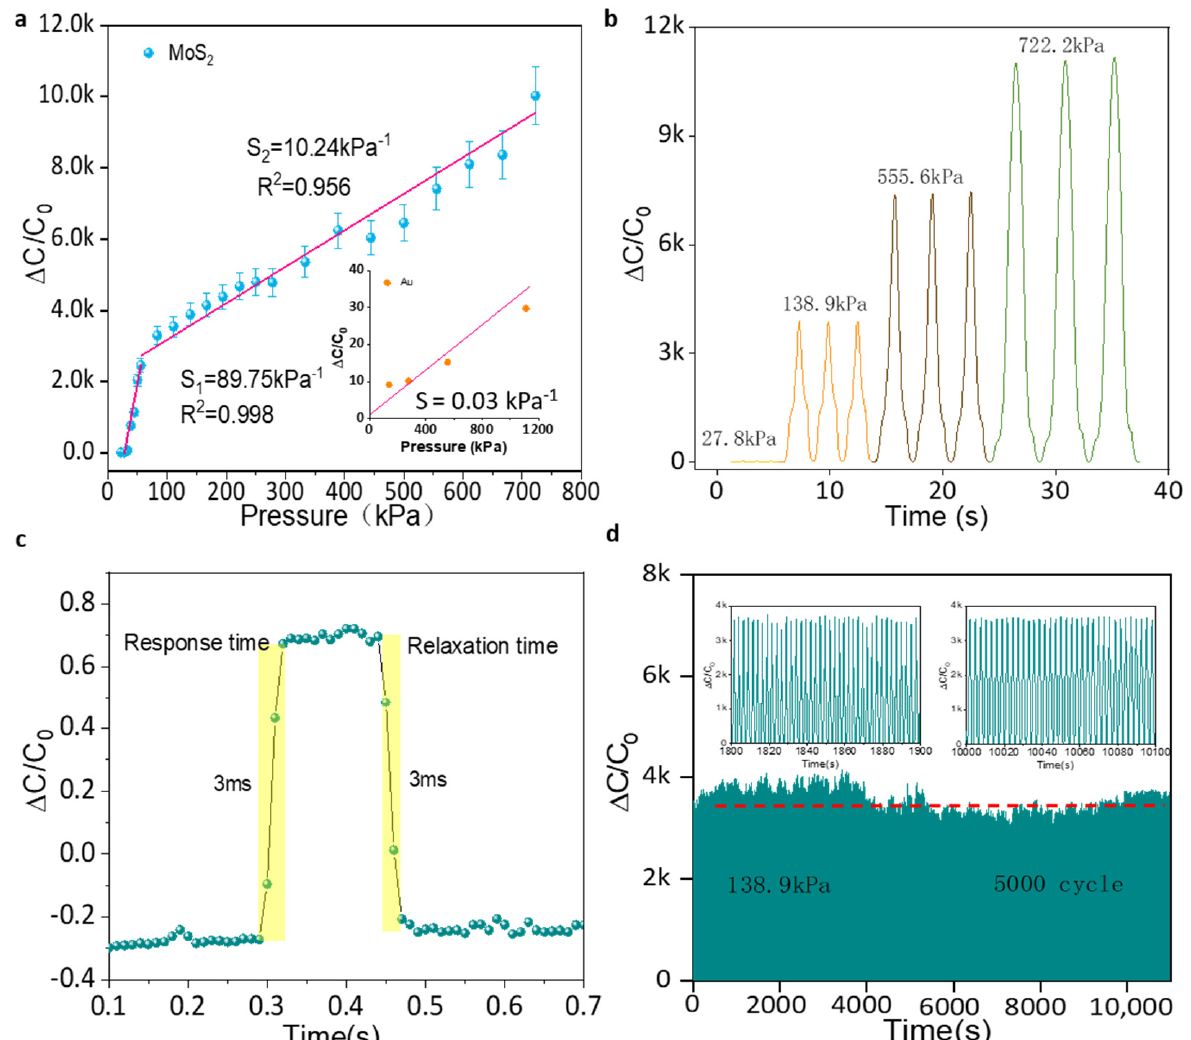
Figure 4. The performance of the flexible sensor. ( a ) Capacitance variation of the sensor under various pressure. ( b ) Continuous pressure test of the sensor. ( c ) Response and relaxation time of the flexible sensor. ( d ) Durability test of the sensor under applied pressure of 138.9 kPa for 5000 cycles. The stability of the sensor subject to the same pressure is also one of the important factors. The sensor was tested under four different continuously pressure of 27.8 kPa, 138.9 kPa, 555.6 kPa, and 722.2 kPa respectively, as shown in Figure 4b. The signal of